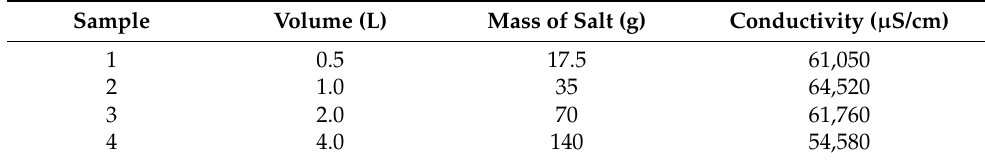
Table 4. Characteristics of the solutions for the experimental